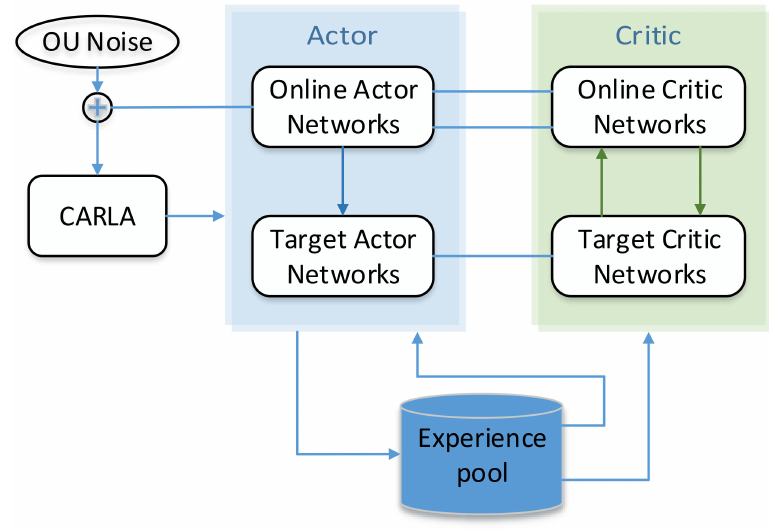
Figure 2. DDPG overall